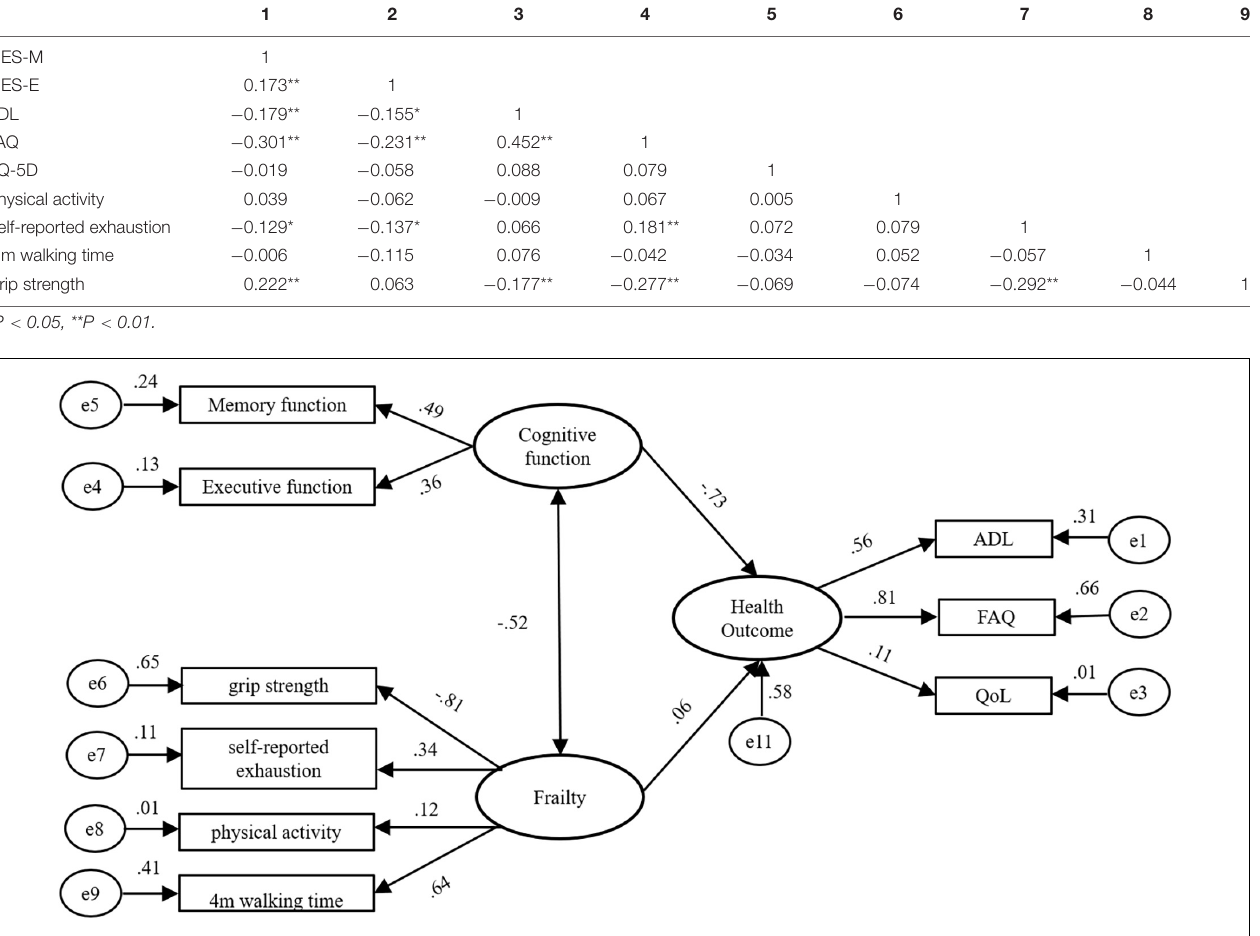
frailty occurs. The influence of cognitive function on health outcomes included direct and indirect effects. There was one path of a direct effect with a path coefficient of − 0.728, and